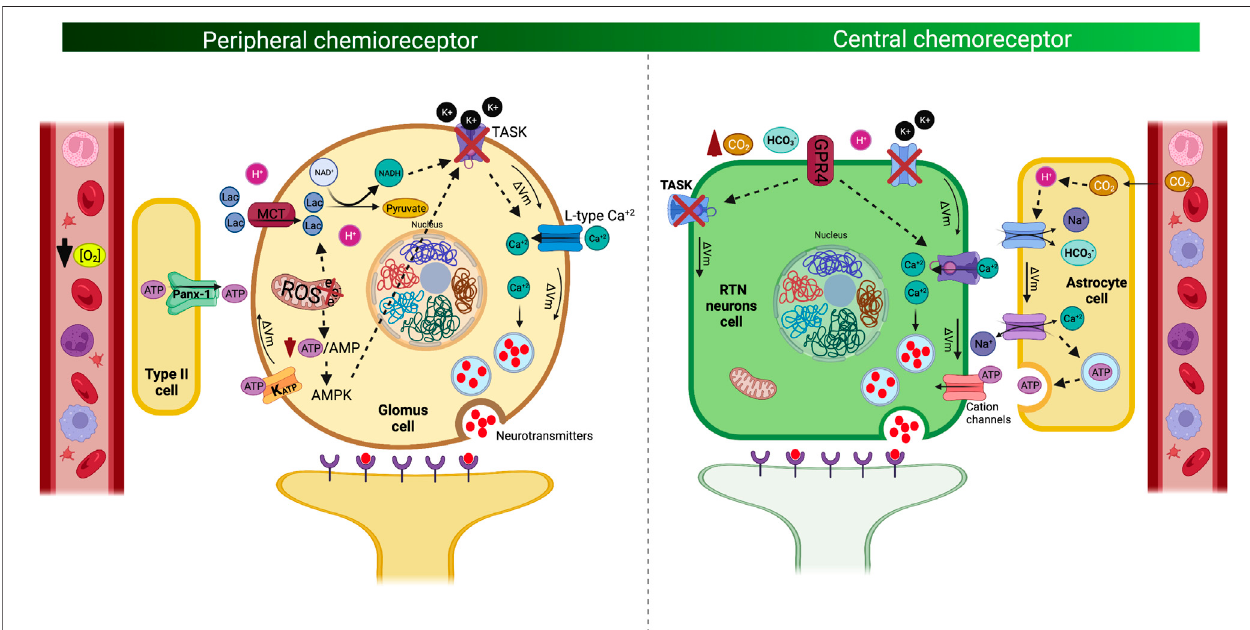
FIGURE 1 | Mechanism of signal transduction and cell excitability of the peripheral chemoreceptor cells. Peripheral chemore fl ex signal transduction mechanism in which type 1 glomus cells are activated by hypoxia (i.e., decrease O 2 bioavailability) and metabolic stress (i.e., lactate) (left panel). Of note, hypoxia inhibits the mitochondrial electron transport, decreasing ATP production, which promotes lactate production and activation of adenosine monophosphate kinase (AMPK). Metabolic shift-dependent lactate production and accumulation which is transported through monocarboxylate cotransporter type 1 (MCT1) increase NADH production, concomitant to AMPK, are the molecular entities responsible for closing K + channels, activating voltage-dependent calcium channel (Ca +2 in fl ux to the cell). In addition, type II cells express Pannexin 1 (Panx-1), by which ATP is released, affecting ATP-dependent K + channels. All this mechanism contributed to induces the release of neurotransmitters such as acetylcholine, dopamine, and adenosine by exocytosis to the carotid sinus nerve. Mechanism of signal transduction and cell excitabilityoftheCentralchemoreceptorcells(rightpanel).Neuronsfromtheretrotrapezoidnucleus(RTN)areactivatedbyCO 2 anditsproxyH + inthecerebrospinal fl uid (pH-sensitive). Acidosis activates the related G protein-coupled receptors 4 (GRP4), which produces closure of tandem pore domain in weakly rectifying K + channels (TWIK), consequently depolarizing the membrane and opening of Ca +2 channels, inducing the release of neurotransmitters by exocytosis, promoting hyperventilation and sympathoexcitation. In addition, RTN neurons possibly also respond to changes in extracellular HCO 3 − concentration by a K + -independent mechanism. Of note, central chemotransduction, algo could be dependent on the astrocytes. The increase of PaCO2, promotes an increase of H + production activating the Na + /Ca 2+ exchanger (NCX), producing the in fl ux of Ca 2+ , which allows the release of ATP by exocytosis from the astrocyte towards extracellular space. The ATP released by the astrocytes activates purinergic receptors of the RTN chemoreceptor neurons, triggering depolarization of these neurons and stimulating the central pattern generator (CPG).